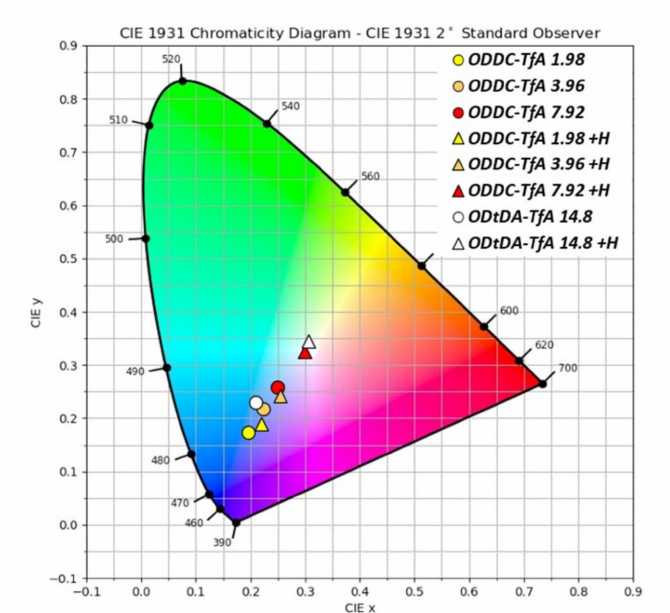
Figure 5. International Commission on Illumination (CIE) coordinates of the fluorescence colors of the PIs of ODDC-TfA and OD t DA-TfA, prepared with variable r values ( r = 1.98, 3.96, 7.92, 14.8) and those doped with H 2 SO 4 (0.5 ~ 1.0 eq., indicated by +H).